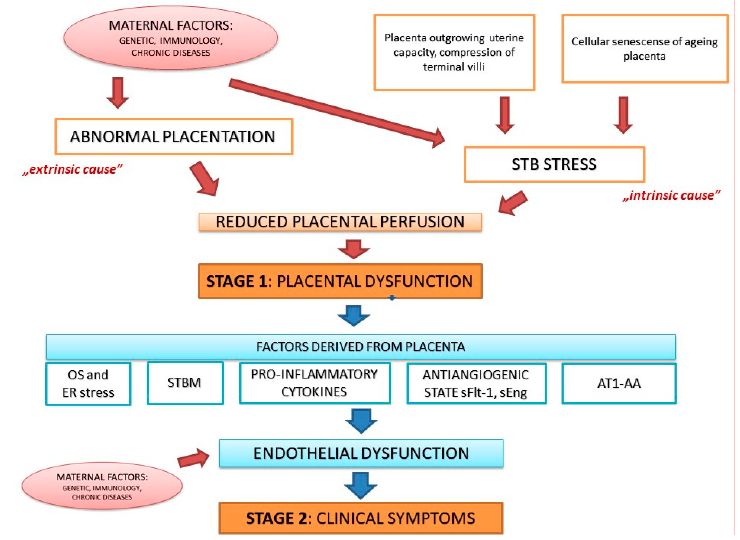
Figure 1. The updated two-stage model of preeclampsia (PE). STB–syncytiotrophoblast, OS–oxidative stress, ER–endoplasmic reticulum, STBM—syncytiotrophoblast microparticles, sFlt-1–soluble fms-like tyrosine kinase 1, sEng—soluble endoglin, AT1-AA—angiotensin II 1 receptor autoantibodies .